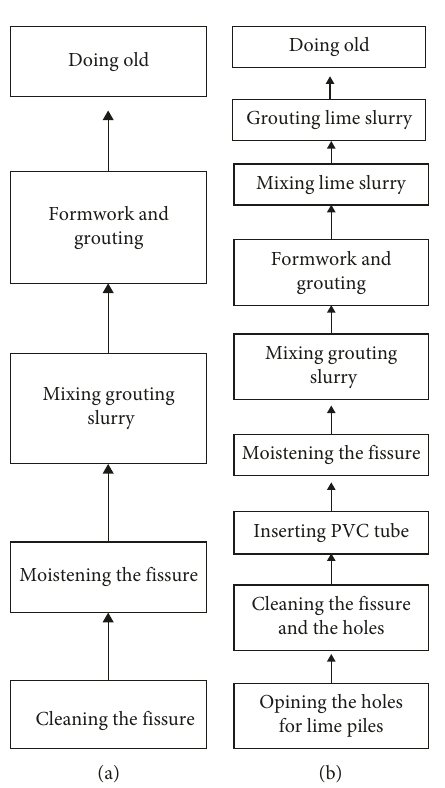
F IGURE 4: Flowcharts of grouting technologies: (a) traditional grouting and (b) optimized grouting with lime